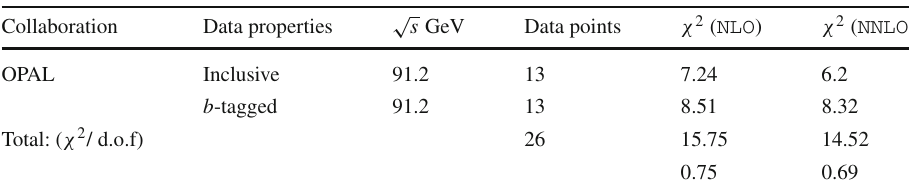
Table 1 The individual χ 2 values for inclusive and b -tagged cross sections obtained at NLO and NNLO. The total χ 2 and χ 2 / d . o . f fit for D 0 are also shown